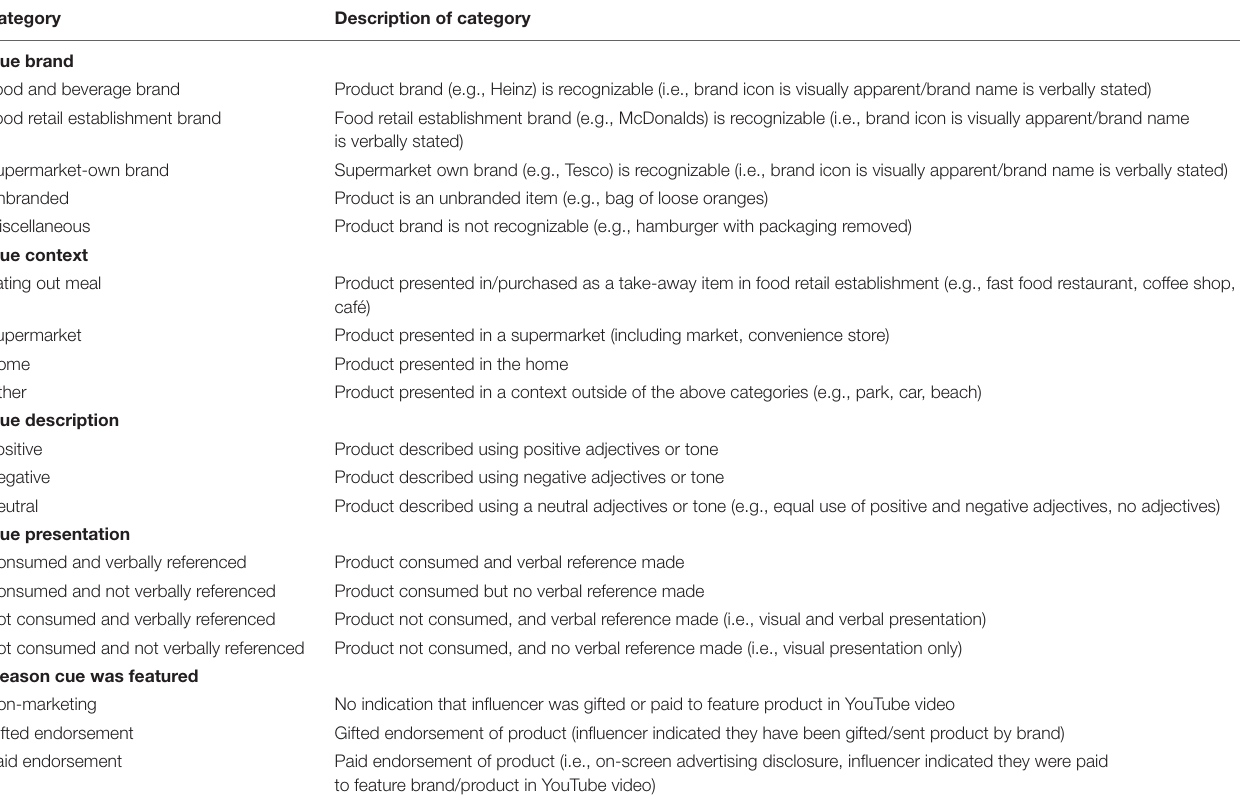
TABLE 1 | Food and beverage cue brand and presentation categories and description. Category Description of